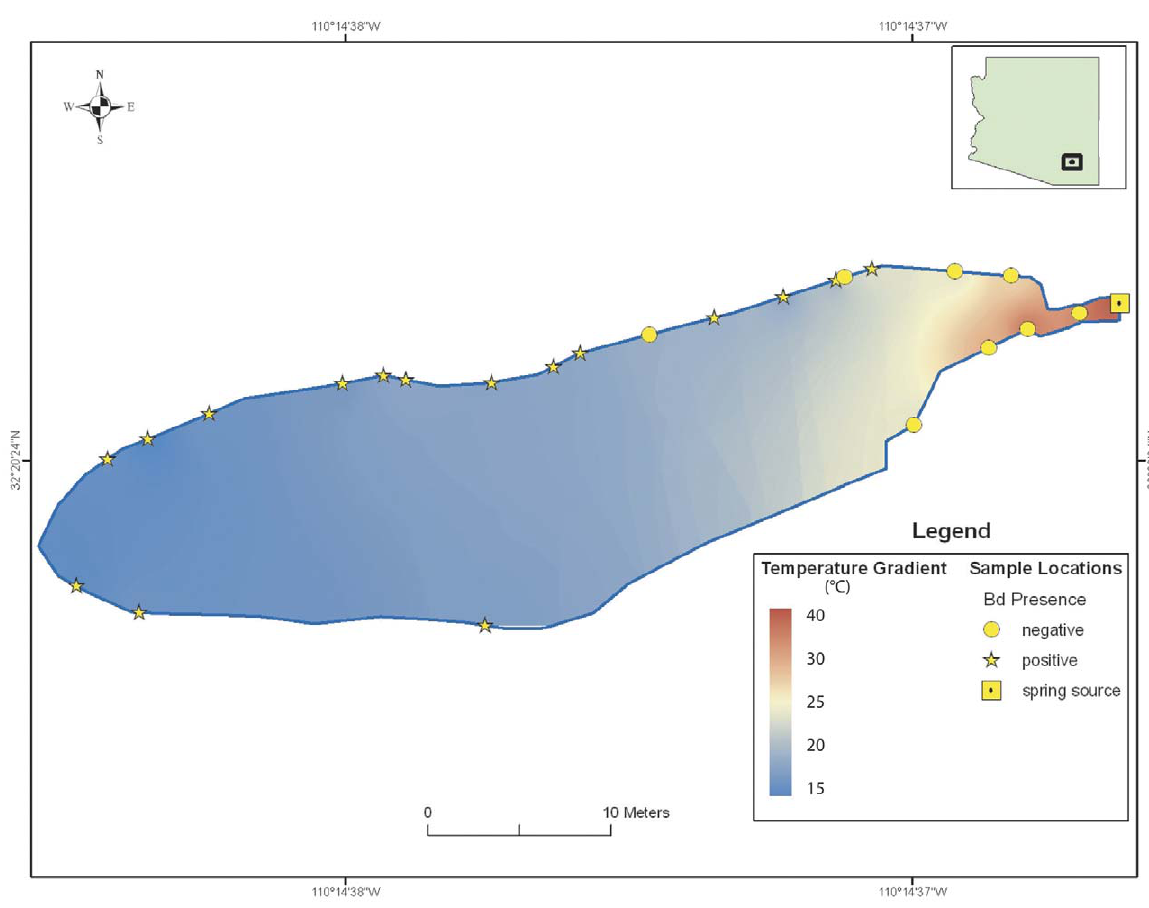
Figure 3. Schematic of Secret Spring showing approximate locations of amphibians and water temperatures. Symbols show approximate locations of lowland leopard frogs (redrawn from field notes) sampled in March 2009, their Bd infection status, and the range of measured water temperatures.